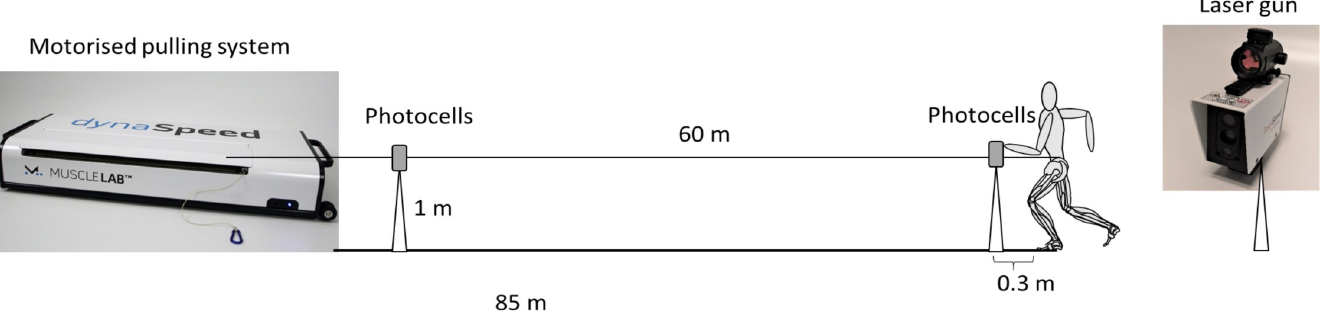
Fig 1. Testing set up with used